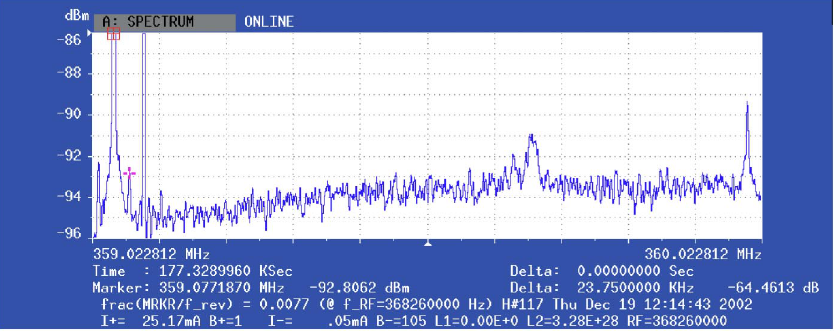
> 23 mA and LFB off. The b